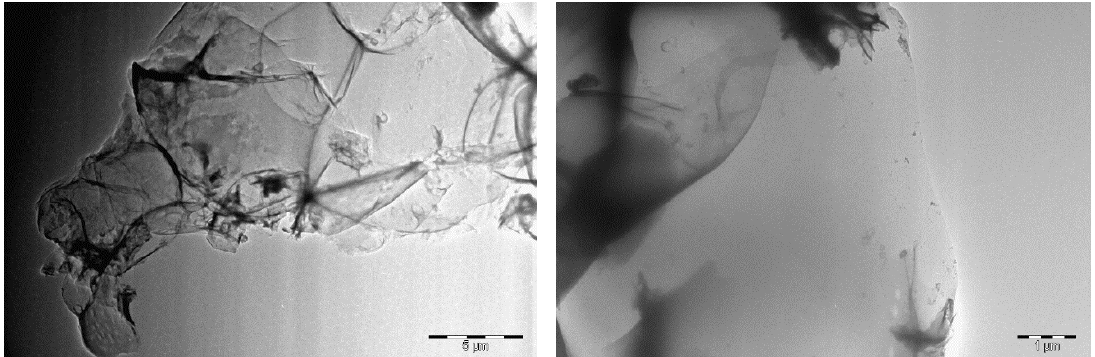
Figure 2. TEM images of ARH-derived graphene layers.